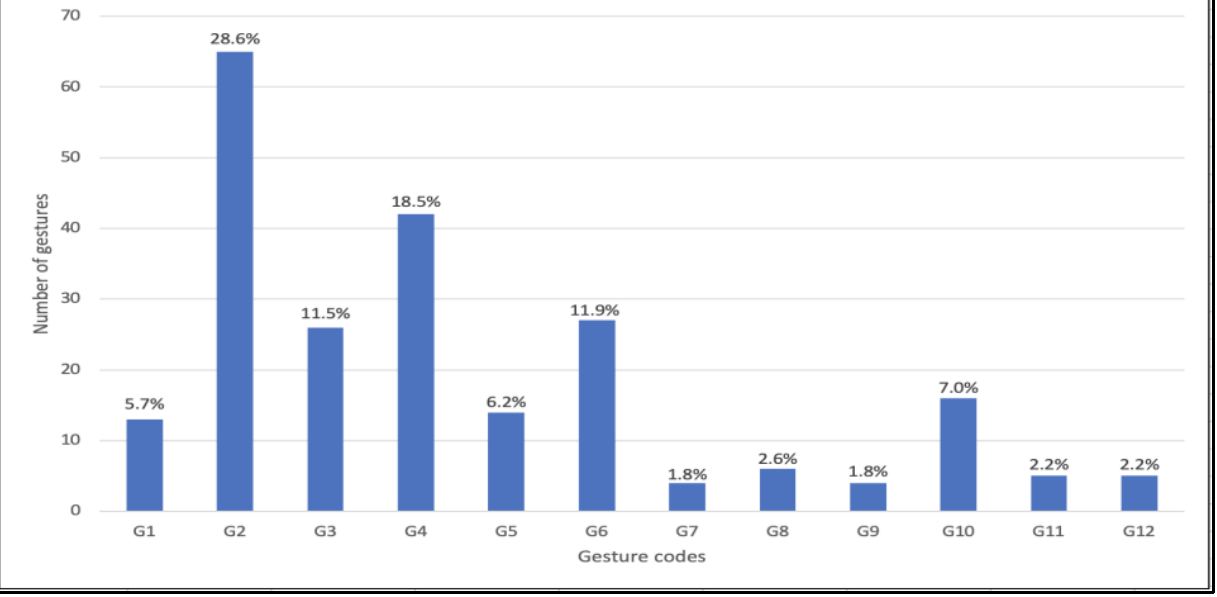
Figure 4. Distribution of each identified gestures based on gesture taxonomy of [10].